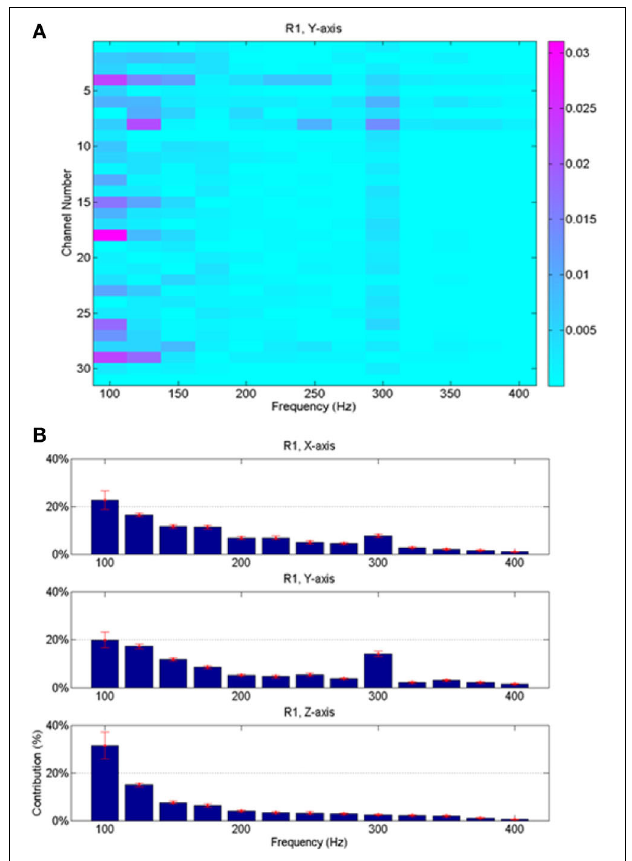
FIGURE 8 | Average neural contributions (from 23 trials shown in Figure 7) in different frequency bands to the reconstructed forces. (A) Contributions from the contacts of the array vs. the frequencies; this plot is for the vertical force only. Each small rectangle indicates the average signal power across multiple trials at the corresponding frequency by the corresponding recording channel multiplied by its regression coefficient. Thus, the unit is the Newton. (B) Contributions from all contacts are lumped together and the mean and standard deviations (across all the trials in the session) are shown as a function of frequency for all three directions of the force. Highest contributions come from lower end of the spectrum, although there is a local maximum around 300Hz for X and Y forces.